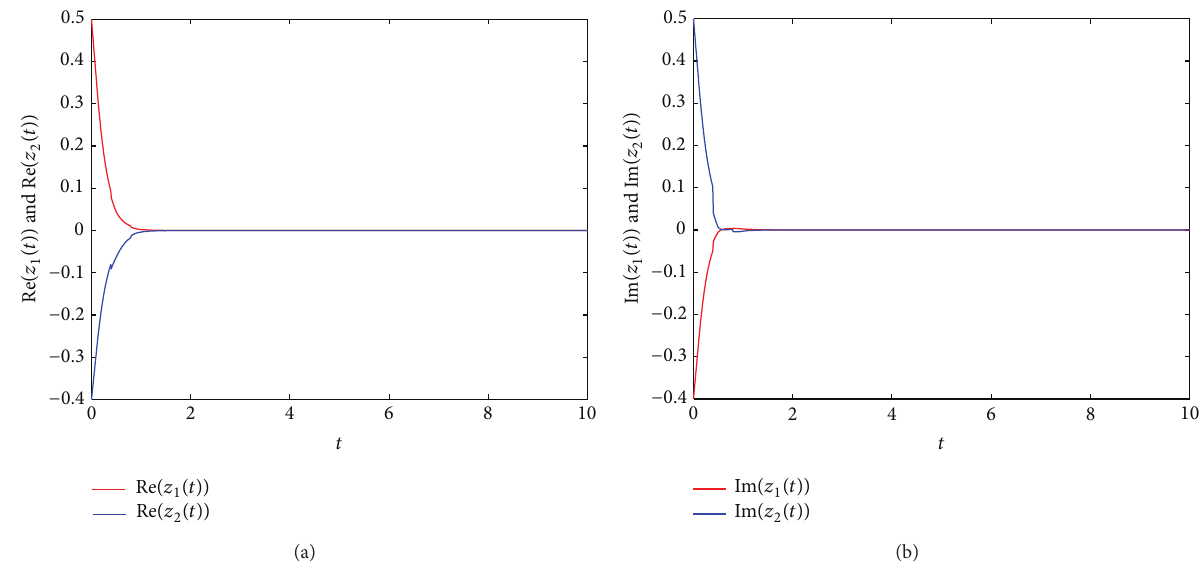
Figure 1: State trajectories of system